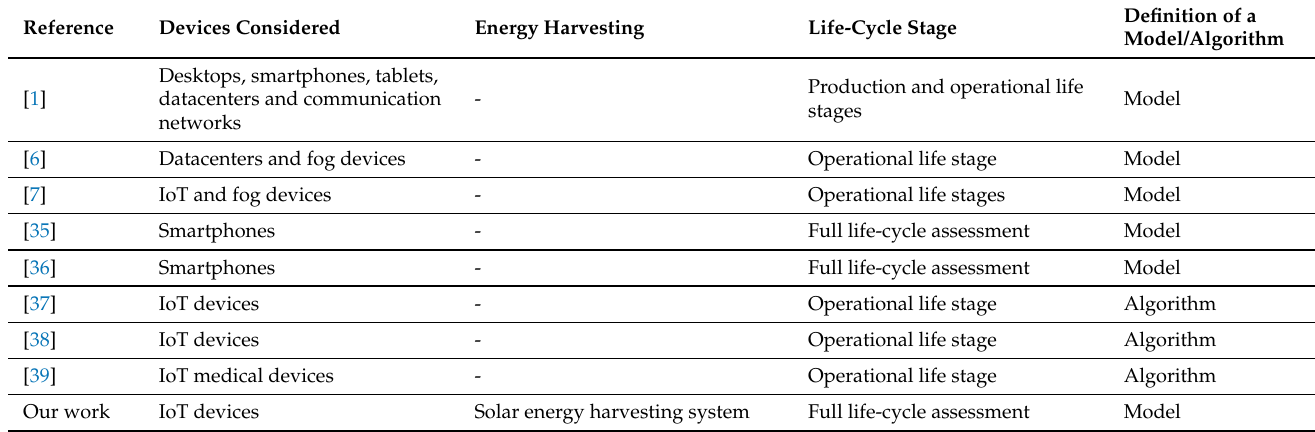
Table 1. Summary of key differences with closest related